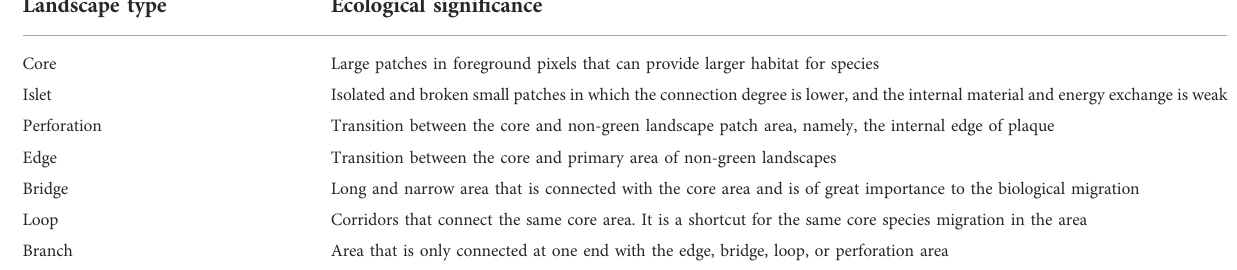
TABLE 1 Ecological signi fi cance of different landscape types. Landscape